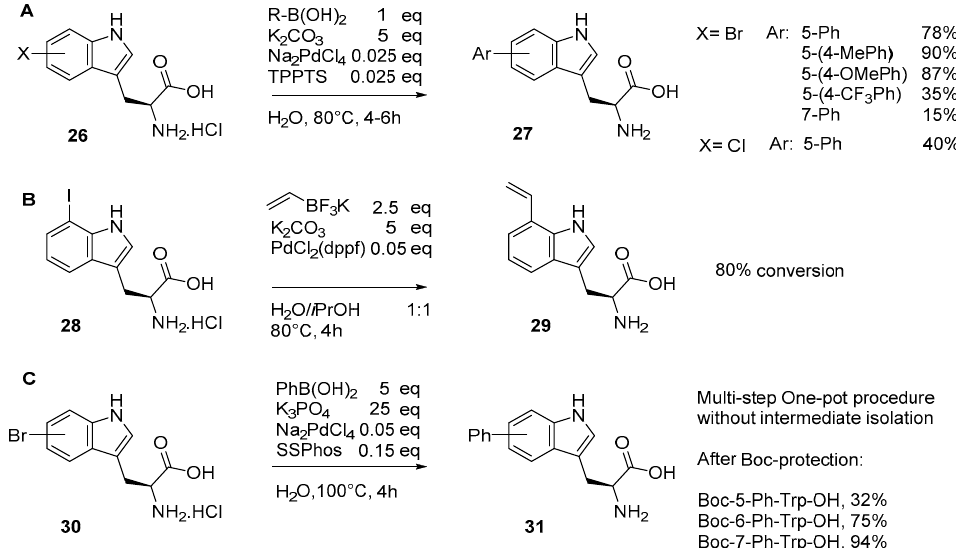
Figure 5. Derivatization of unprotected halotryptophans in aqueous conditions: ( A ) Arylation. ( B ) Vinylation. ( C ) Multistep one-pot biocatalytic halogenation presented 30 , followed by Suzuki– Miyaura reaction.